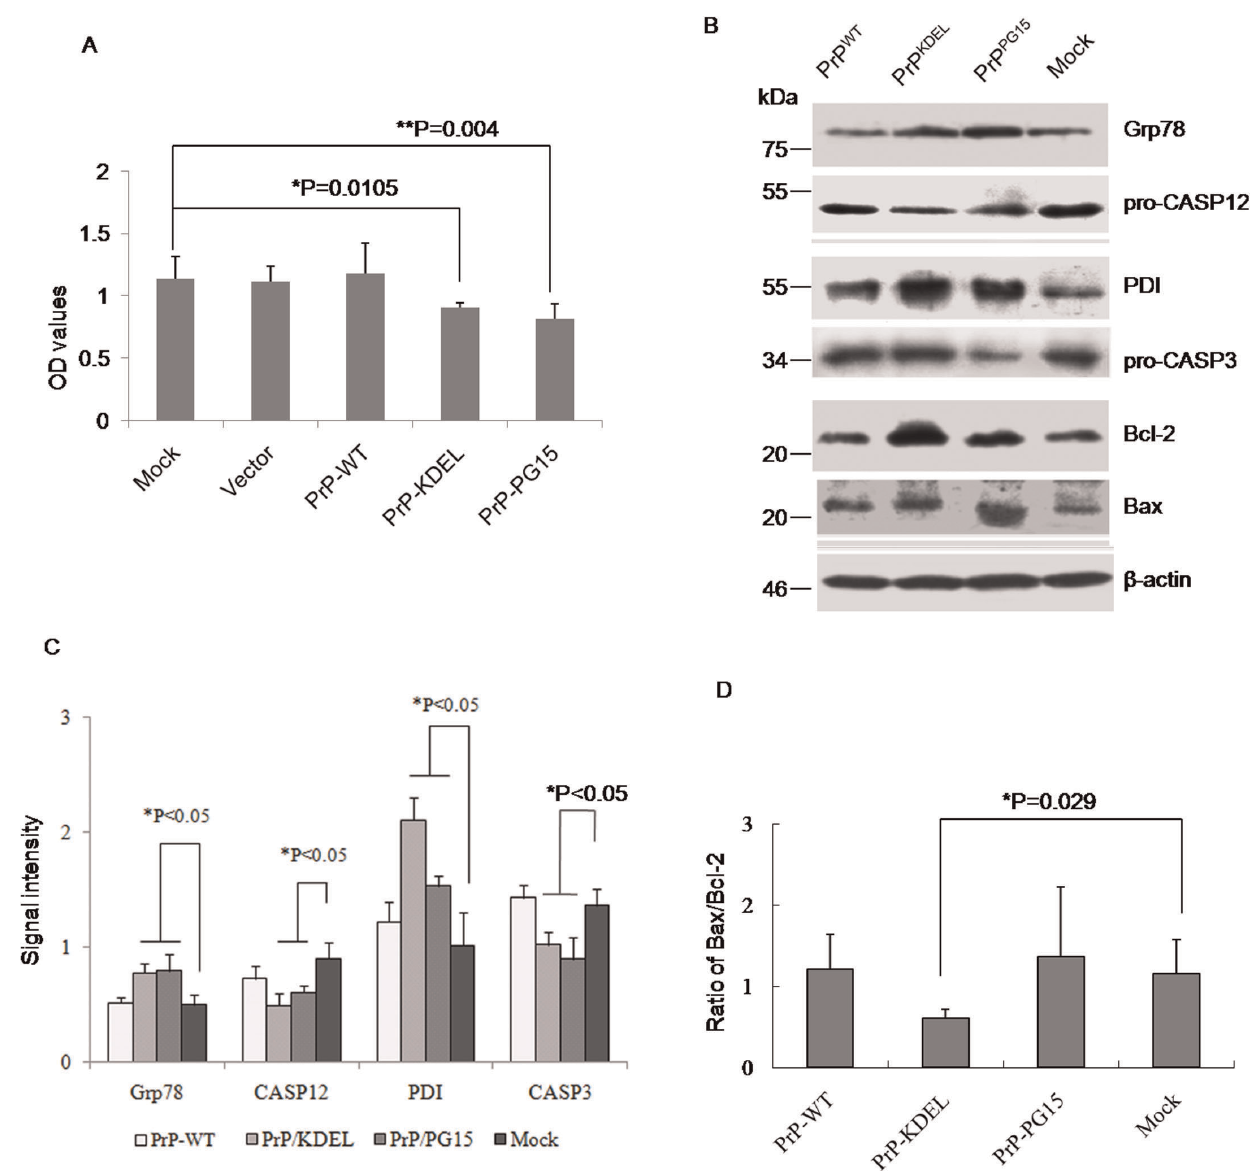
Figure 3. Influences of expression of various PrP constructs on the cell viability and the relevant cellular factors. A. Cell viabilities assayed by CCK-8 kit. Each group is assigned to three repeating parallel units and measured with a spectrophotometer under 450 nm. The results are calculated from three independent tests and indicated as mean 6 SD. Statistical differences compared with controls are illustrated as *P , 0.05. B. Western blots. Cell lysates were separated in 15% SDS-PAGE and the specific immunoblots for Grp78, pro-caspase12, PDI, pro-caspase3, Bcl-2 and Bax were detected with individual antibodies. C. Quantitative analysis of each gray numerical value of Grp78, pro-caspase12, PDI, pro-caspase3 vs that of individual b -actin. The results are calculated from three independent tests and presented as mean 6 SD. Statistical differences compared with controls are illustrated as *P , 0.05. D. The relative densities of Bcl-2 and Bax specific bands normalized to b -actin are presented as ratio of Bax/Bcl-2. Statistical differences compared with controls are illustrated. misfolded PrP mainly accumulated in the ER, but has a limited (Fig. 4B). Western blots of cell lysates identified that, in the effect on the apoptosis of other organelles. preparation co-expressing PDI and PrP KDEL , the levels of Grp78, pro-caspase-12, and pro-caspase-3 recovered to a degree com- parable to the control, whereas levels of pro-caspase-3 in the preparation co-expressing PDI and PrP PG15 were obviously lower than the controls (Fig 4C and D). Additionally, levels of Bax in those two preparations were still higher than controls (Fig. 4E). It seems that overexpression of PDI in cultured cells sufficiently releases ER stress and antagonizes apoptosis induced by